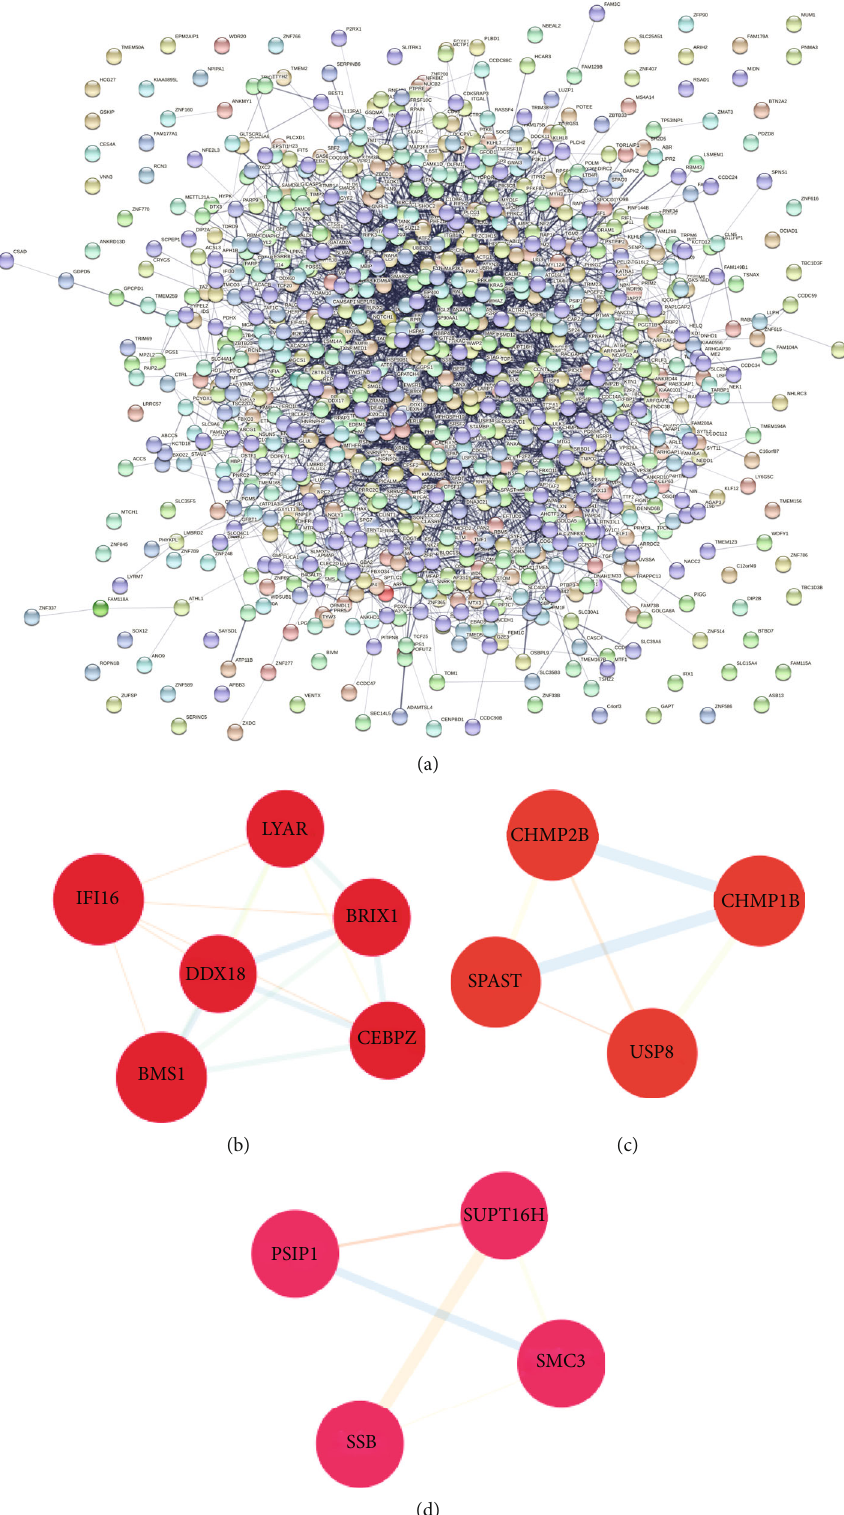
Figure 4: Construction of hub gene interaction networks and subsets. (a) Interaction network of related gene in 882 DEGs; (b) subnets with high scores were identi fi ed by the Cytoscape plugin MCODE. Subnets containing 6 hub genes were identi fi ed with a score of 12.08. (c) Subnets containing 4 hub genes were identi fi ed with a score of 4.01. (d) Subnets containing 4 hub genes were identi fi ed with a score of